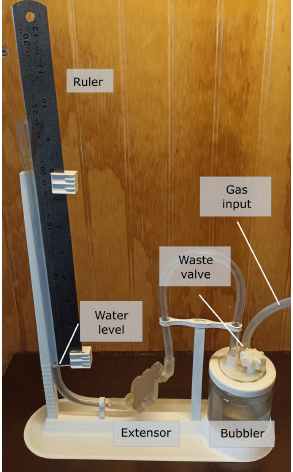
Figure 8. Assembled measurement system.